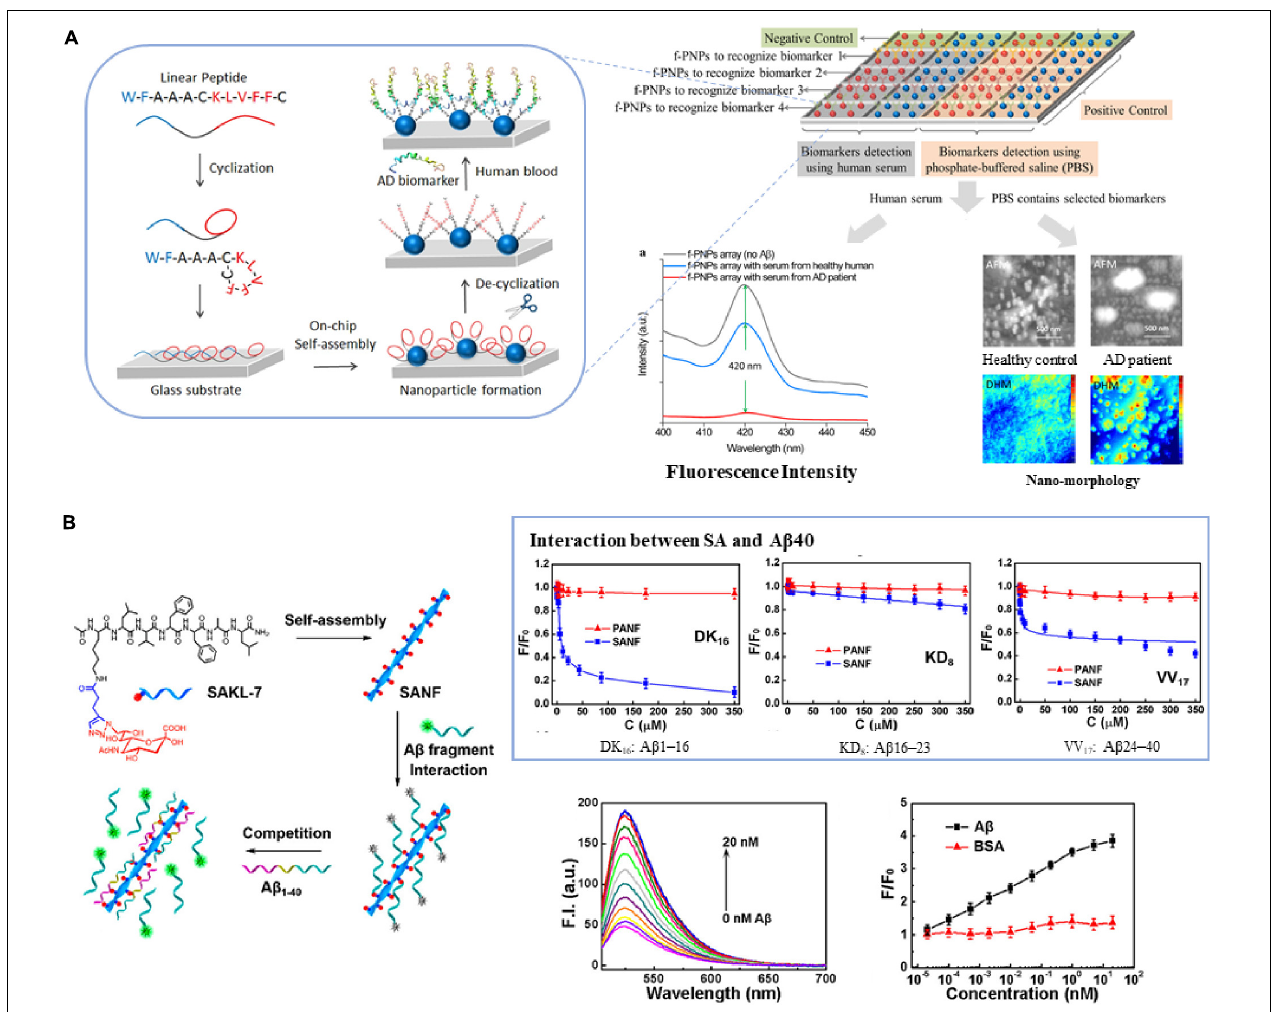
FIGURE 1 | The core region KLVFF of A β is used as (A) recognition element of biosensors (Sun et al., 2018), (B) carrier for signal amplification (Lei et al., 2019). Reproduced with